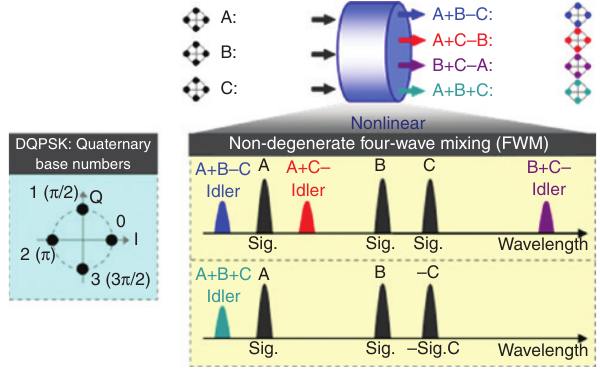
Figure 13: Serial, optics-friendly Internet checksum. Figure 14: Modular arithmetic via wave mixing